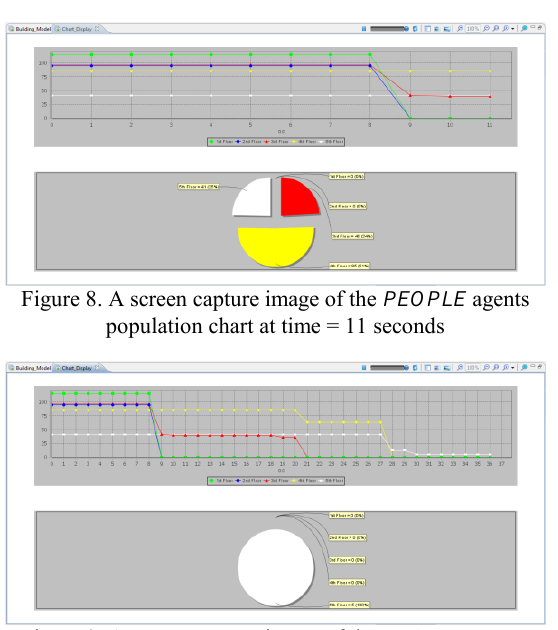
Figure 9. A screen capture image of the PEOPLE agents population chart at time = 36 seconds